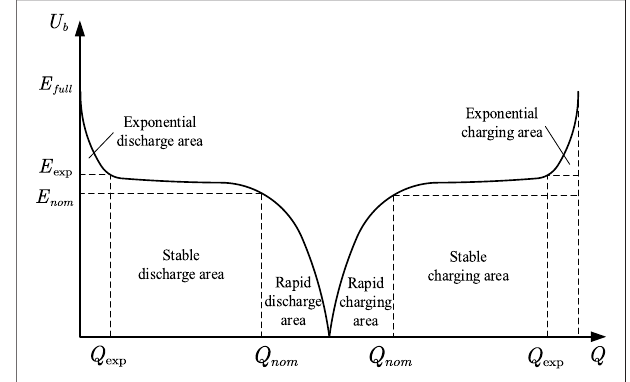
FIGURE 5 | Typical charge and discharge waveform of a